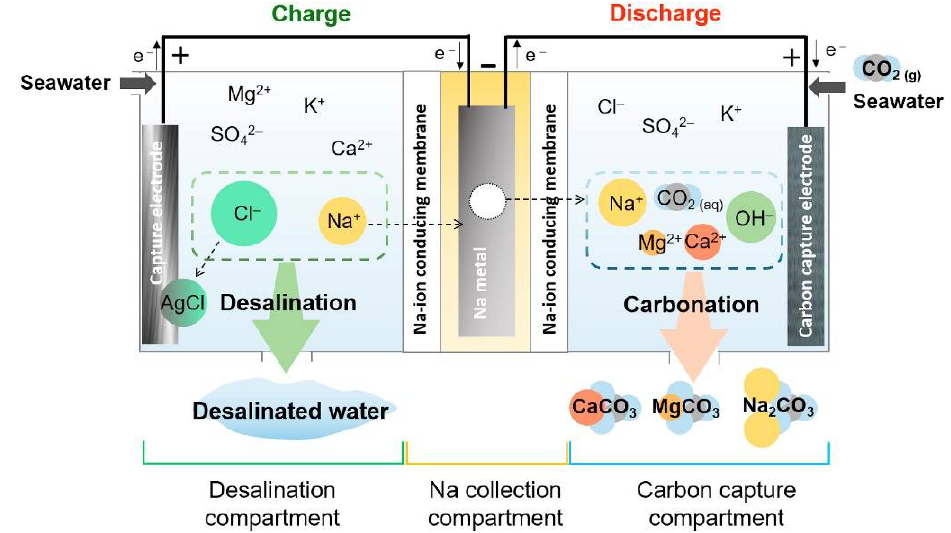
Figure 7. Schematic representation of the hybrid desalination–carbon capture system (SD–CC system). Reproduced with permission from [98], Elsevier, 2019.